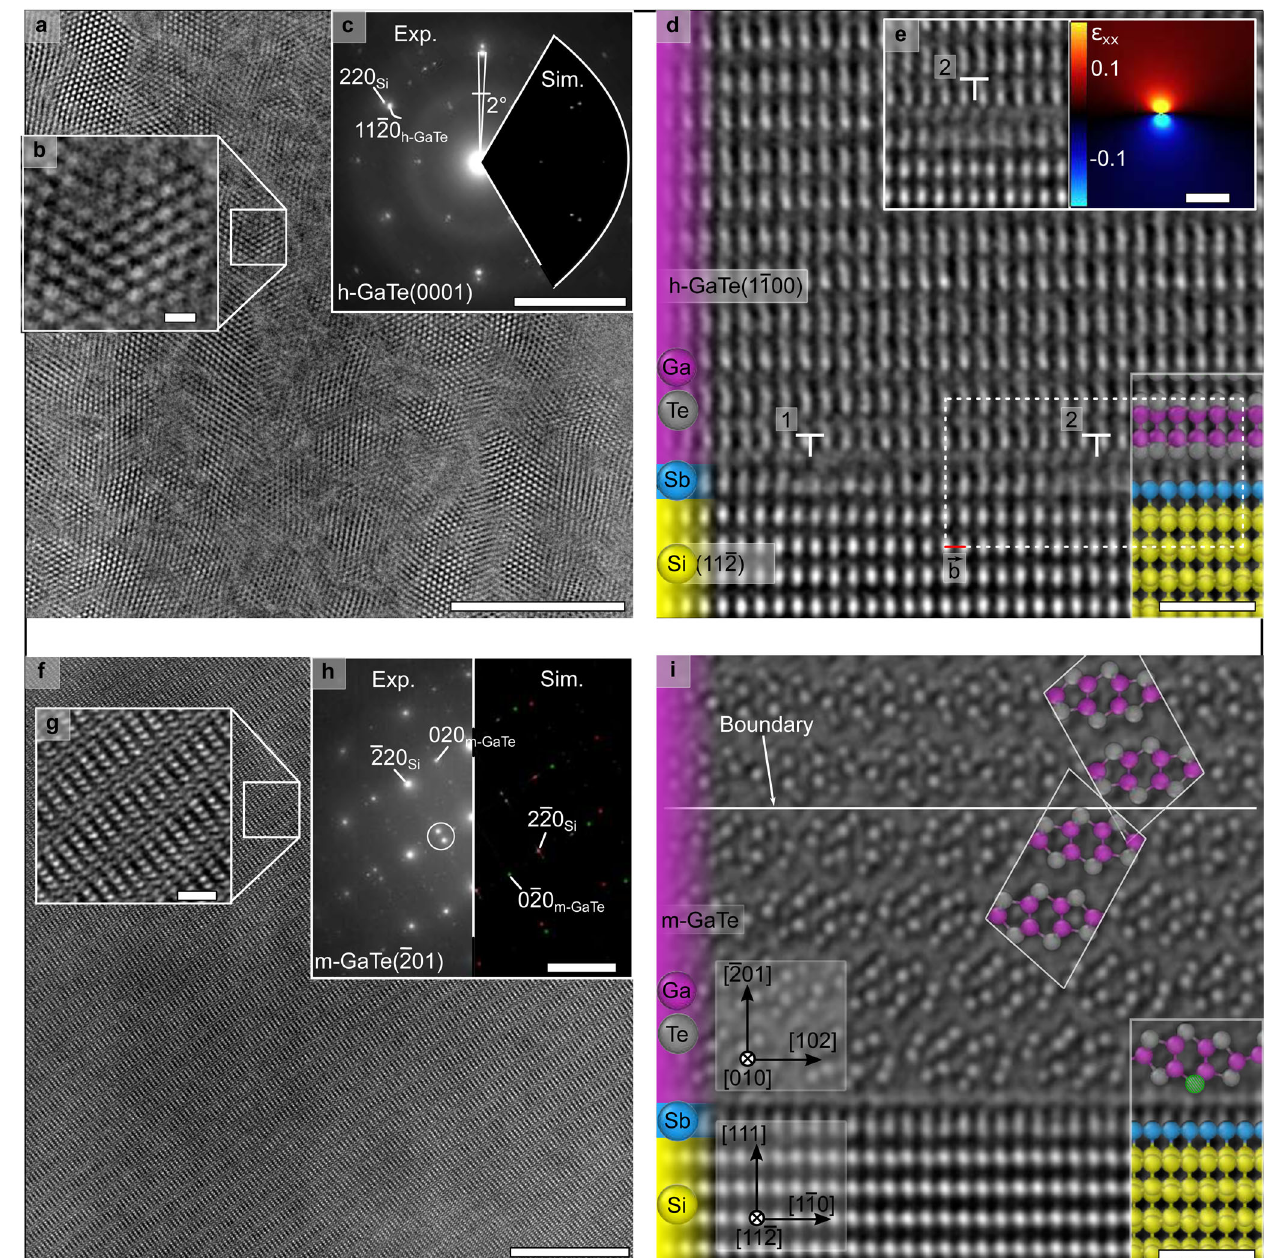
Fig. 3 Electron microscopy studies of as-grown h-GaTe and m-GaTe on Si. a , f Bright fi eld plan-view micrograph of as-grown h-GaTe and m-GaTe (h-GaTe after RTA annealing). The scale bar is 100 nm and 10 nm, respectively. The insets ( b , g ) show zoomed fragments (scale bar is 5 nm and 1 nm, respectively) and ( c , h ) diffraction patterns obtained along Si(111) (scale bar is 5 nm − 1 ). d , i Cross sectional high-resolution (HR)- TEM image of as-grown Si/h-GaTe and Si/m-GaTe interfaces and near interface regions, respectively (scale bar is 1 nm). Panel ( d ) illustrates the mis fi t dislocations arisen at the interface between Si( 112 ) and nonrotated h-GaTe( 1100 ). e ϵ xx component of the strain fi eld around the mis fi t dislocation core. The color scale indicates strain changes of − 20% to 20% (scale bar is 0.5 nm). Panel ( i ) shows the codirection of m-GaTe[020] and Si[ 112 ] with “ twin-like ” boundary highlighted by white solid